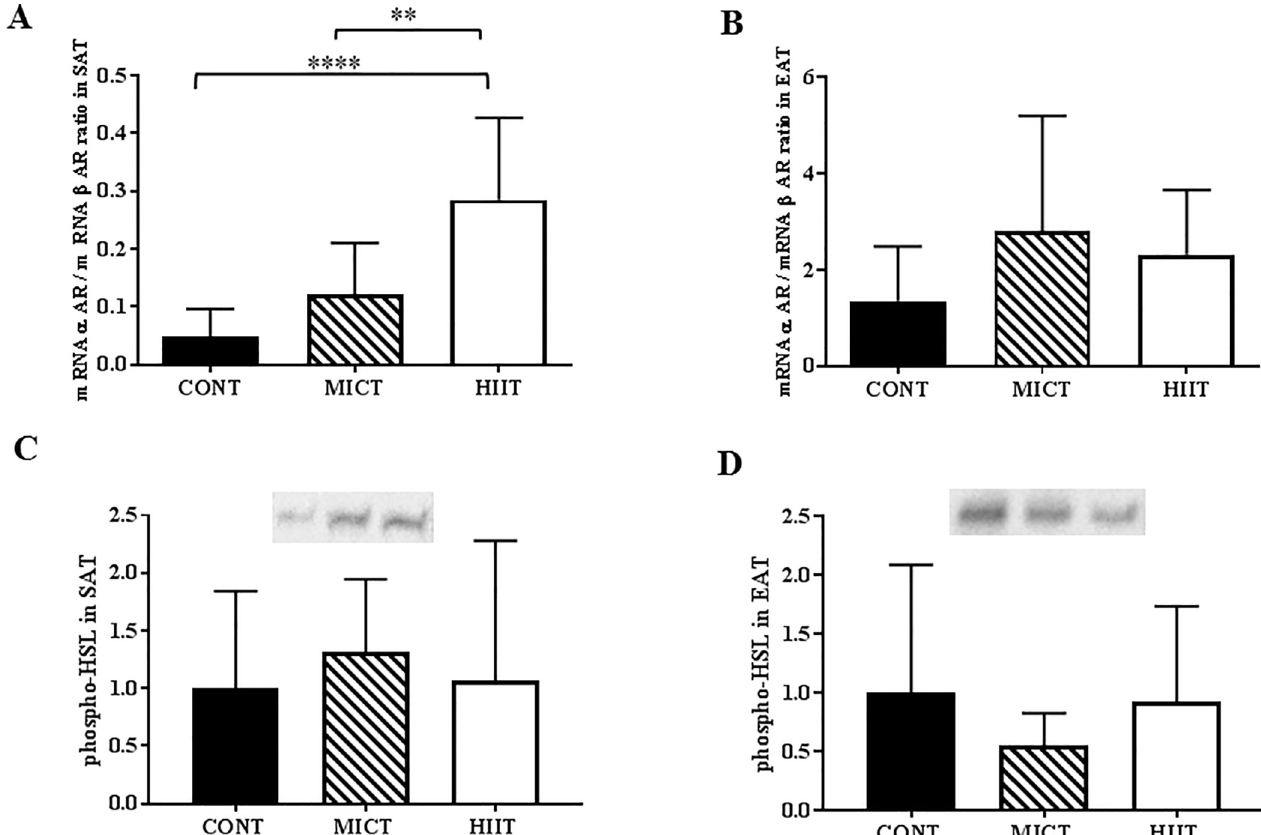
Fig 6. Effect of 10 weeks of exercise training on lipolysis factors. The α -adrenergic receptor/ β adrenergic receptor ( α AR/ β AR) ratio determined by q-PCR in subcutaneous adipose tissue (A) and epididymal adipose tissue (B). Level of phosphorylated hormone-sensitive lipase (phospho-HSL) in subcutaneous adipose tissue (C) and epididymal adipose tissue (D). Data are expressed as the mean ± SD; �� p � 0.01 and ��� p � 0.001.